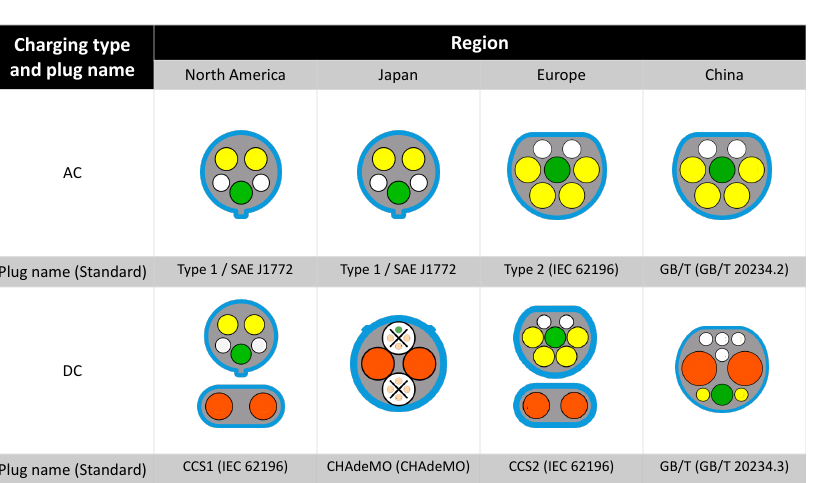
Figure 11. Types of connectors for electric vehicle